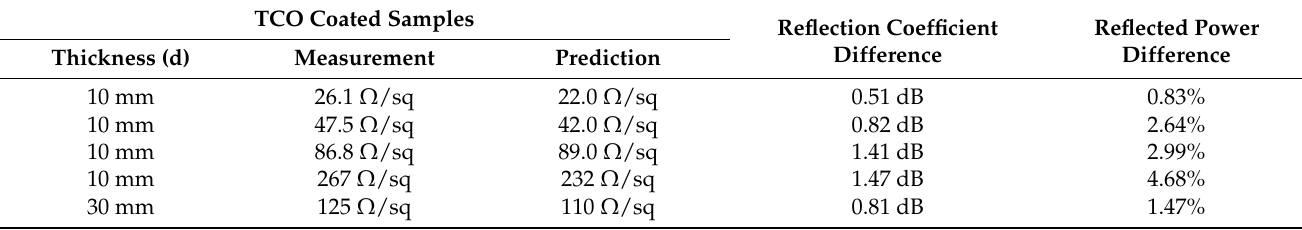
Figure 7. Measurement results of reflectivity for optical transparent absorbers that have different thickness and surface resistance: ( a ) single-side (low Rs) coated acrylic and ( b ) double-side (high Rs/low Rs) coated acrylic. Table 1. Comparisons for reflectivity between prediction and